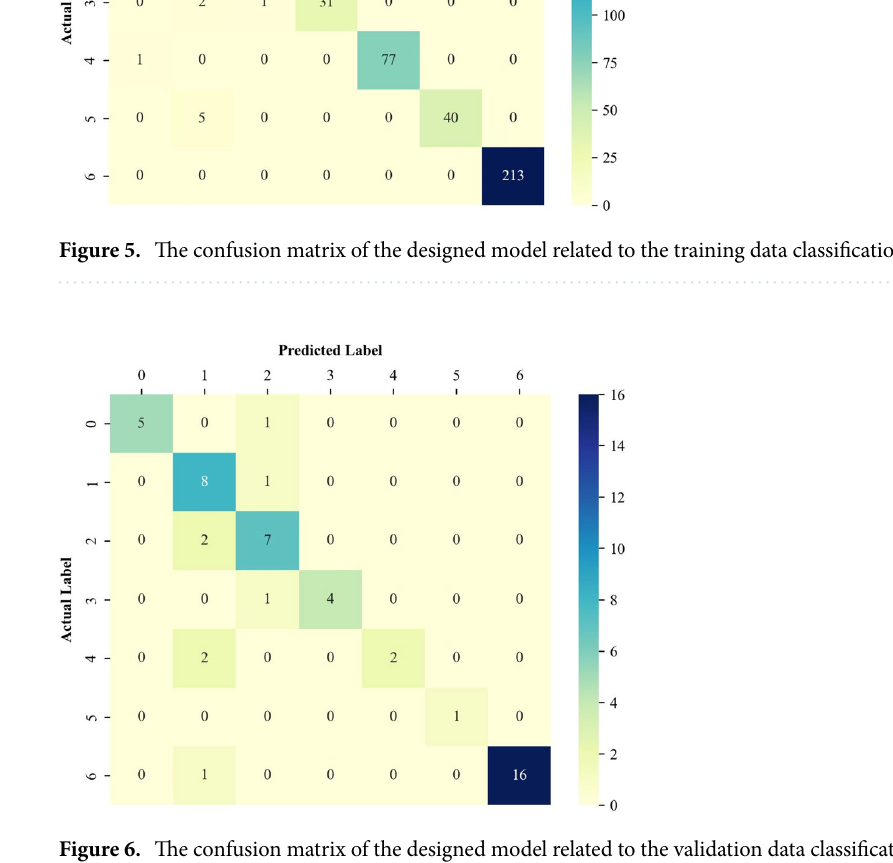
Figure 6. The confusion matrix of the designed model related to the validation data classification.